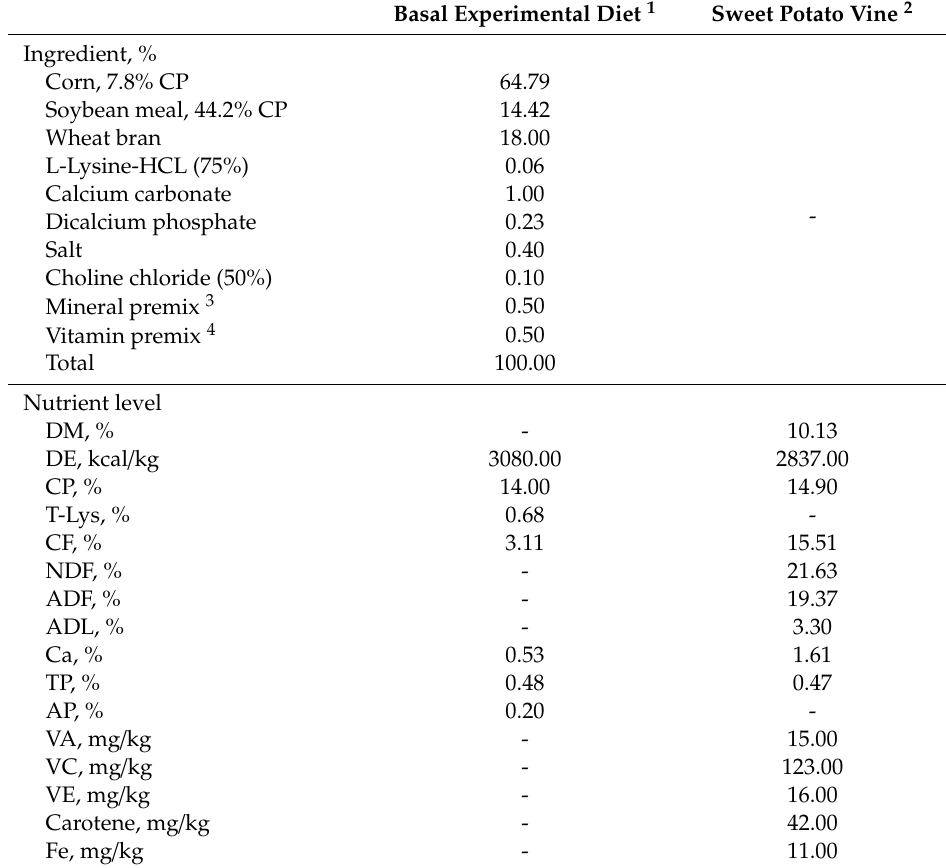
Table 1. Composition and nutrient level of basal experimental diet (as-fed basis), chemical composition of sweet potato vine for the Chinese Meishan gilts.